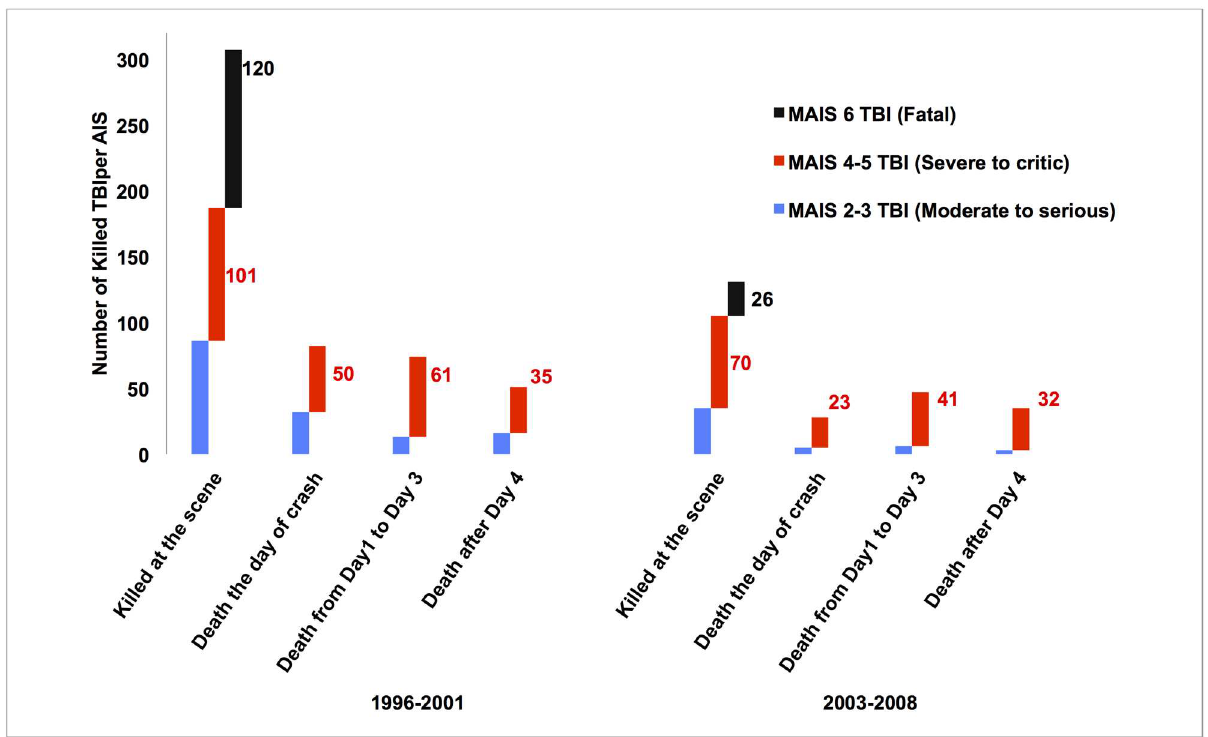
Fig 3. Number of RTC-related TBI victims who deceased in the two periods according to their head-MAIS status and the delay from crash to